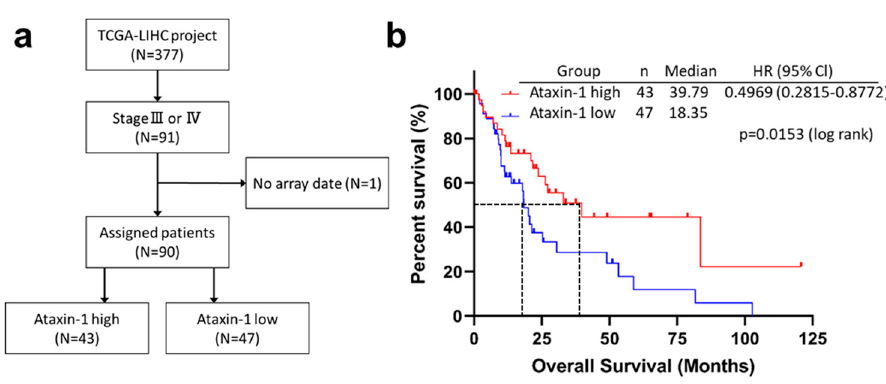
Figure 9. ATXN1 expression was significantly associated with the overall survival of patients with advanced HCC. ( a ) A flowchart of cohort selection from the public database. Among the TCGA–LIHC dataset, patients with Stage III or IV ( n = 91) were selected, and one patient was excluded due to lack of array data. Ninety patients were divided into two groups according to high or low expression of ATXN1. ( b ) Kaplan–Meier survival curves for overall survival. HR, hazard ratio; CI, confidence interval. The p -value was calculated by log-rank test.